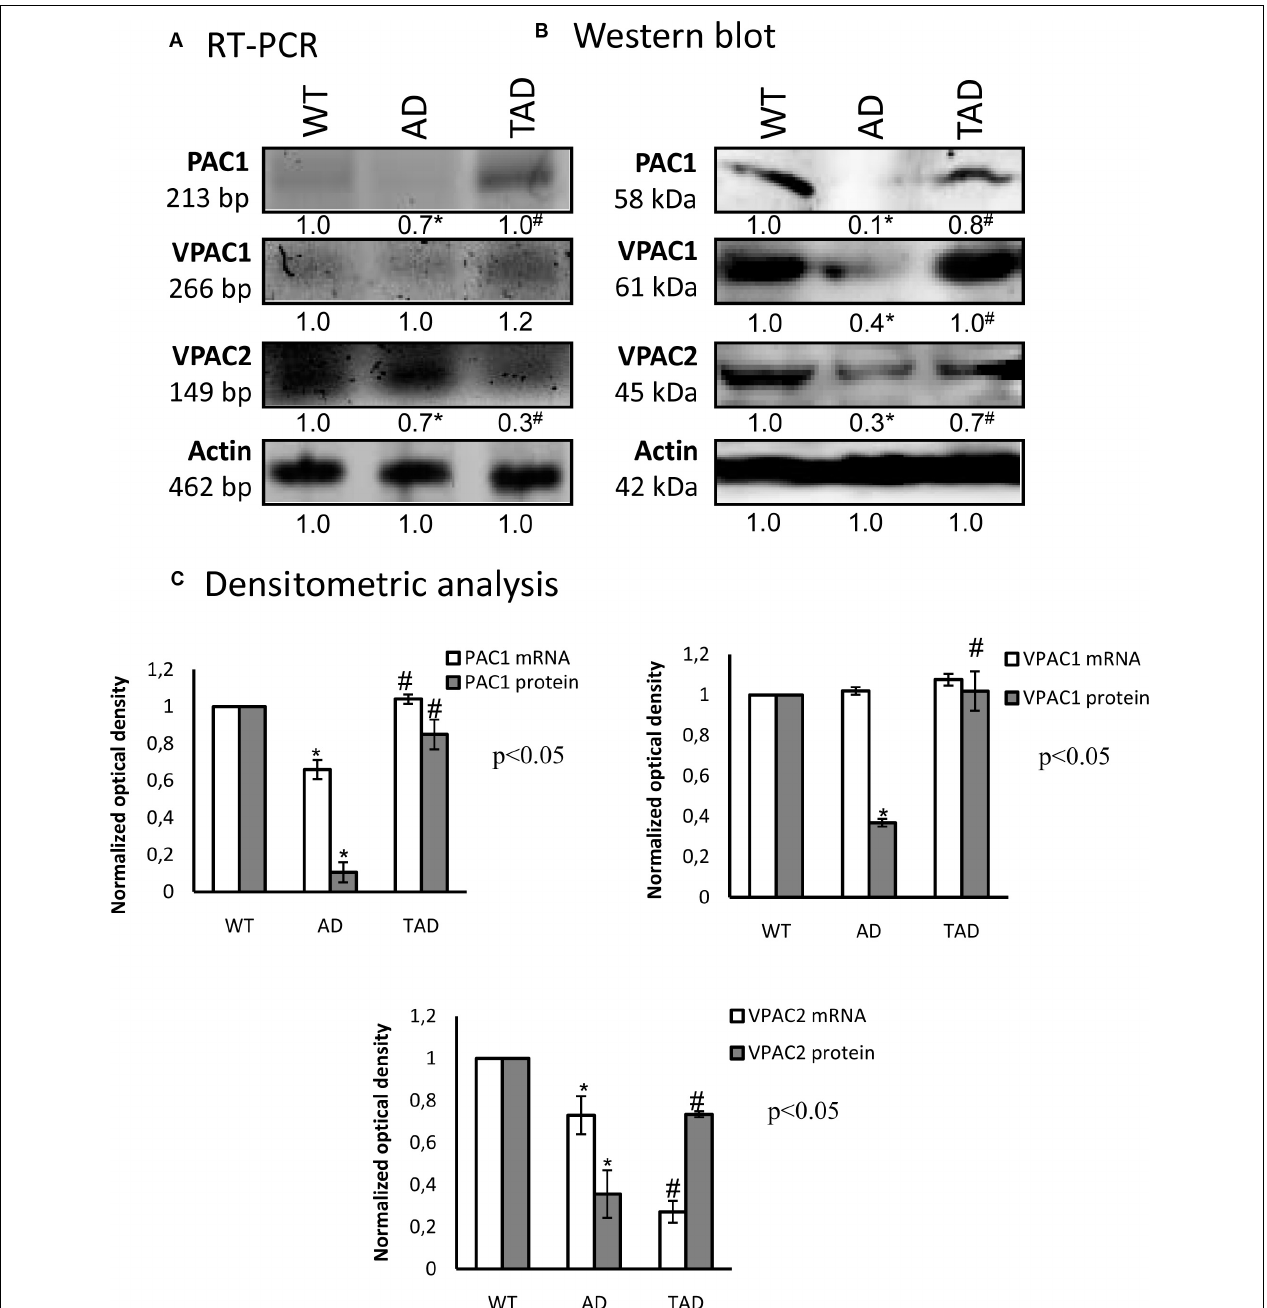
FIGURE 2 | mRNA (A) and protein (B) expressions of pituitary adenylate cyclase-activating polypeptide (PACAP) receptors in the kidneys. The optical density of the signals was measured and the results were normalized to the optical density of the wild type (WT). For (A,B) , the numbers below the signals represent the integrated densities of the signals determined by ImageJ software. Asterisks indicate significant ( ∗ p < 0.05) alterations of expressions as compared to the WT and ( # p < 0.05) compared to Alzheimer’s disease (AD). Representative data of five independent experiments. For reverse transcription PCR (RT-PCR) and for Western blot, actin was used as the control. (C) Statistical analysis of the RT-PCR and Western blot data. All data presented are the averages of at least five different experiments. Statistical analysis was performed with Student’s t- test. All data were normalized on actin and are expressed as the mean ± SEM.